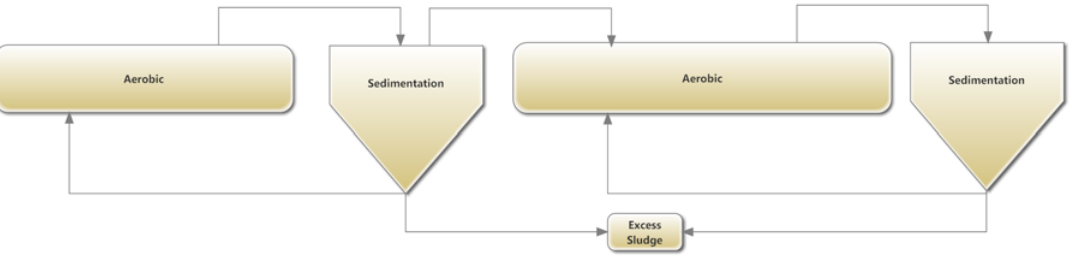
Figure 2. Fruit processing industry’s wastewater treatment plant (WWTP ‐ 2) flowchart.